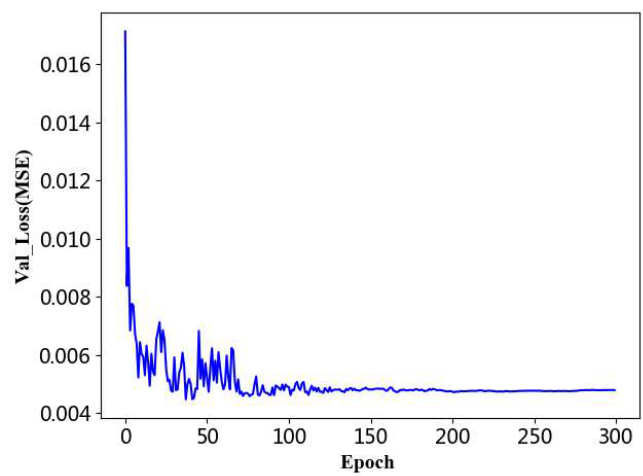
Figure 17. The loss function declining curve with epoch of the validation dataset.